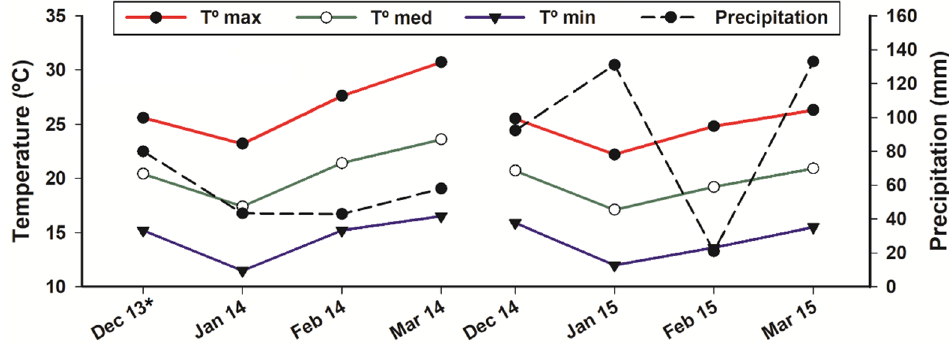
Figure 5. Accumulated precipitation (mm) and average monthly temperatures (°C) in Acateno, Puebla, Mexico from December 2013 to March 2014 and December 2014 to March 2015 (Source SMN, 2019 [36]). * Data are the historical average of the parameters presented since there is no data available for this month.